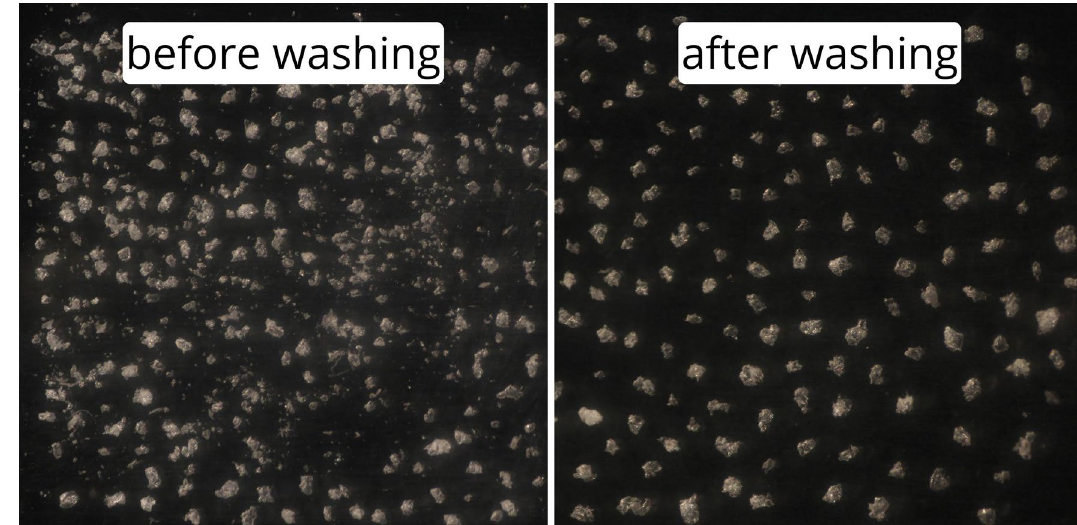
Figure 3. Polypropylene microfragments (150–300 μm) before and after washing in 0.1% Tween-80 solution. Microfragments were mixed at 600 rpm for ten minutes to separate ultra-fine microplastics that were contaminating the size fraction.